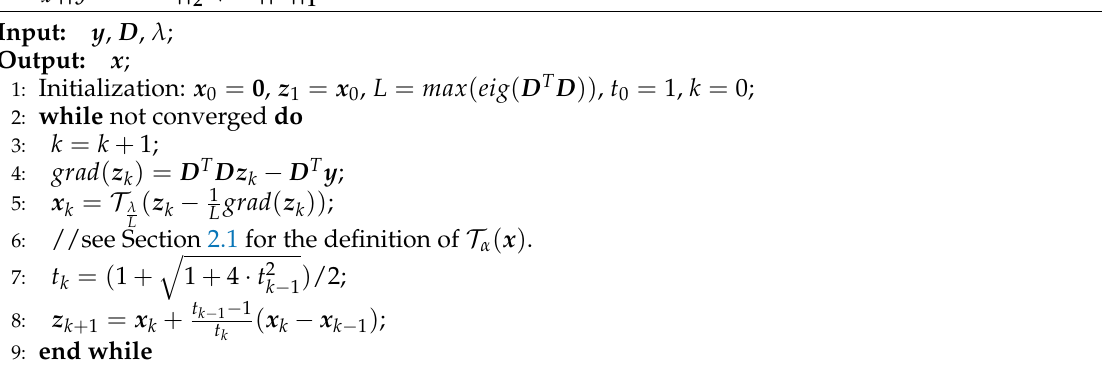
Algorithm 3 Fast iterative shrinkage-thresholding algorithm (FISTA) [25] to solve LASSO problem: